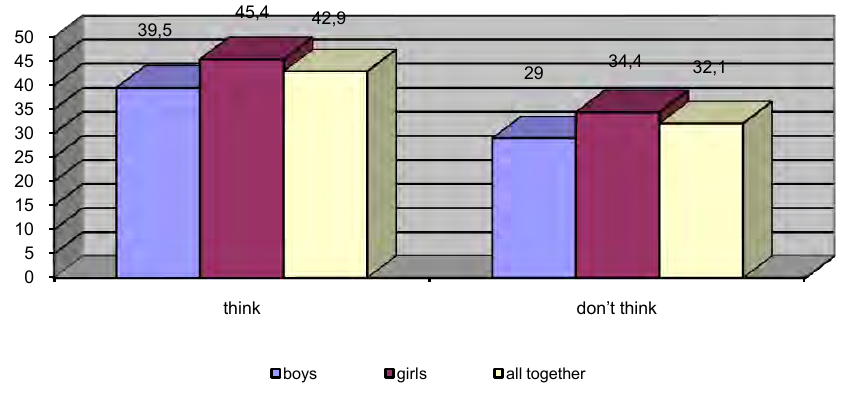
Fig. 6. Schoolchildren’s attitude to the values followed by the Olympic champions in sports and everyday life The question “Would you like to become an Olympic champion?” was answered affirmatively by a total of 56.8% of the schoolchildren, among whom 60% are from rural and 55.6 % – from urban area. Male respondents (70.2%) showed greater willingness to achieve this high title (Fig. 7).